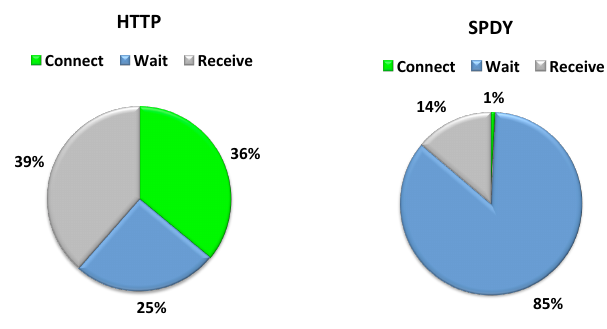
Figure 6. Percentages of the OLTs computed over the entire